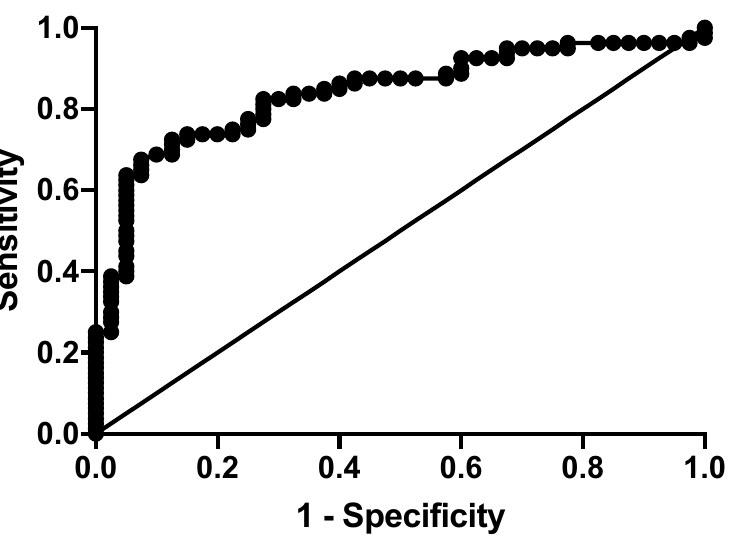
Fig 2. ROC curve analysis of serum Hsp90 levels to predict autoantibody-positivity in subjects � 18 years of age. ROC analysis was performed to determine the utility of serum Hsp90 levels as a predictor of autoantibody-positivity in subjects � 18 years of age. (AUC: 0.84; 95% CI: 0.77–0.91; P < 0.0001).